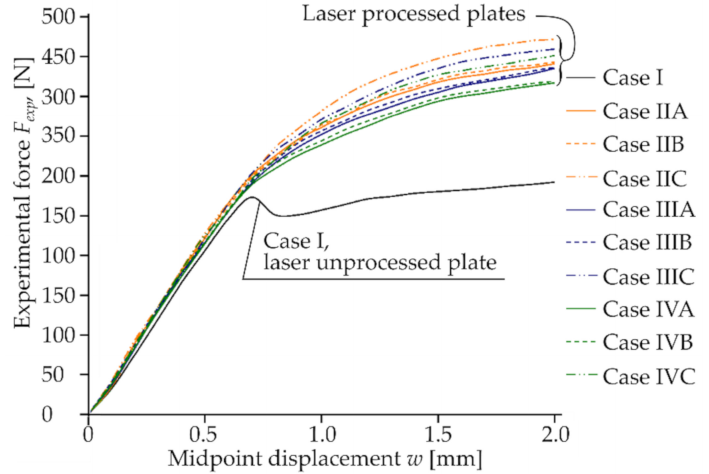
Figure 11. Experimental bending force F exp vs. deflections w of the middle point of the di ff erently laser-processed